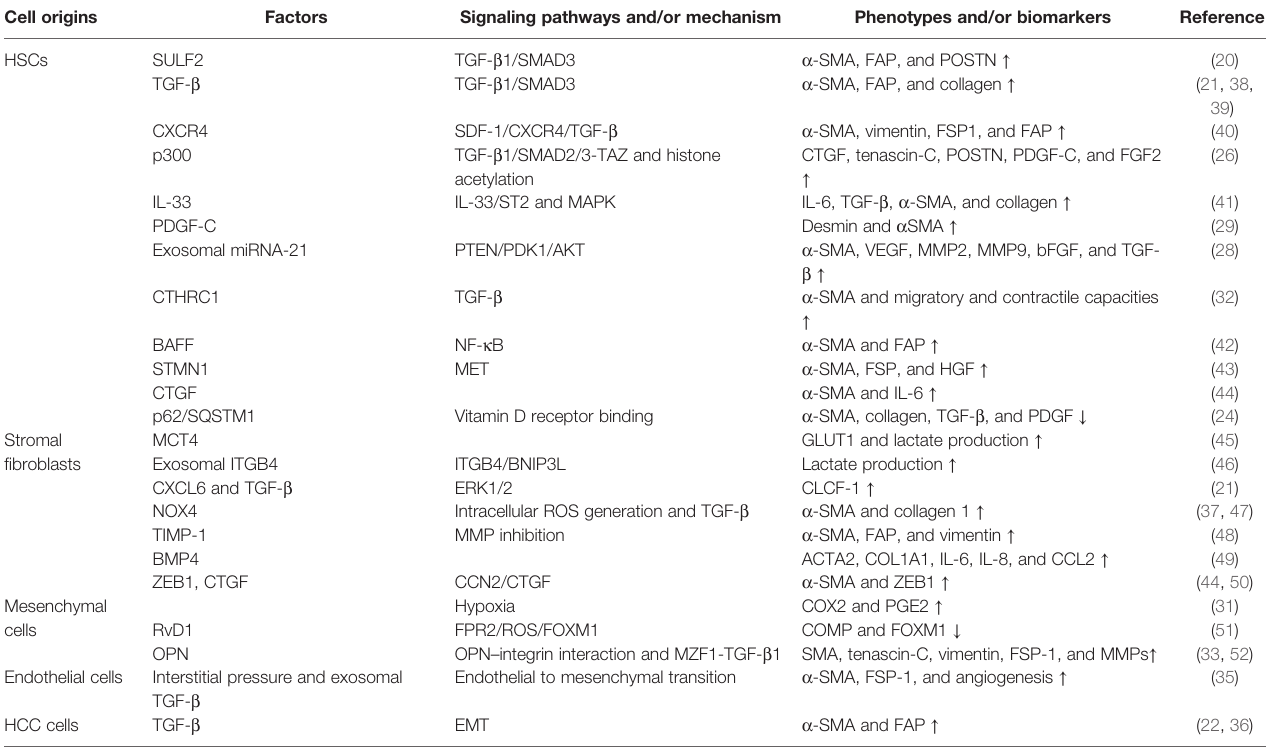
TABLE 1 | The factors and pathways for CAF activation in the tumor/premalignant